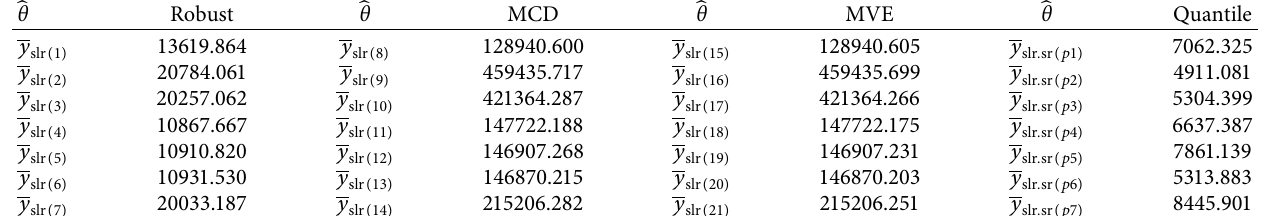
Table 3: MSE for population-1 (nonsensitive).